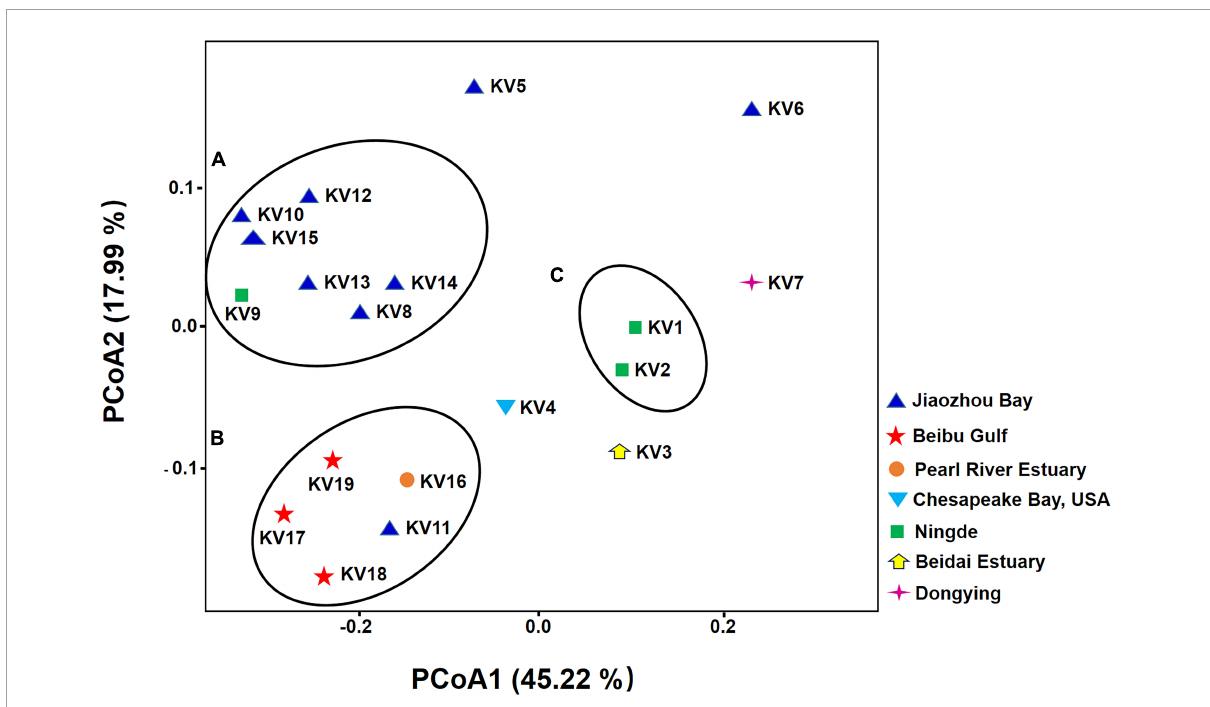
FIGURE2 Principal coordinate analysis (PCoA) of bacterial community based on weighted-unifrac distances. The color of the symbols indicate the original isolation sources of samples.